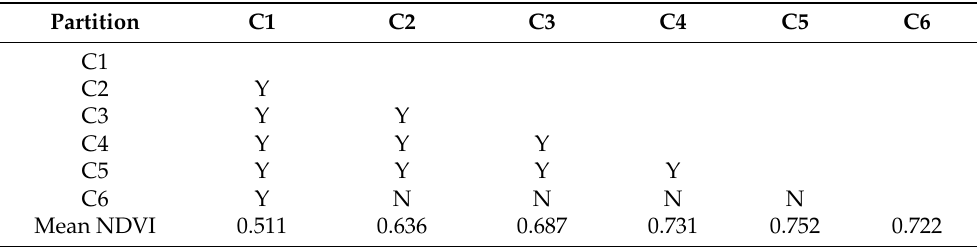
Table 9. Mean vegetation NDVI and statistical significance for every two divisions of slope (95% confidence level).